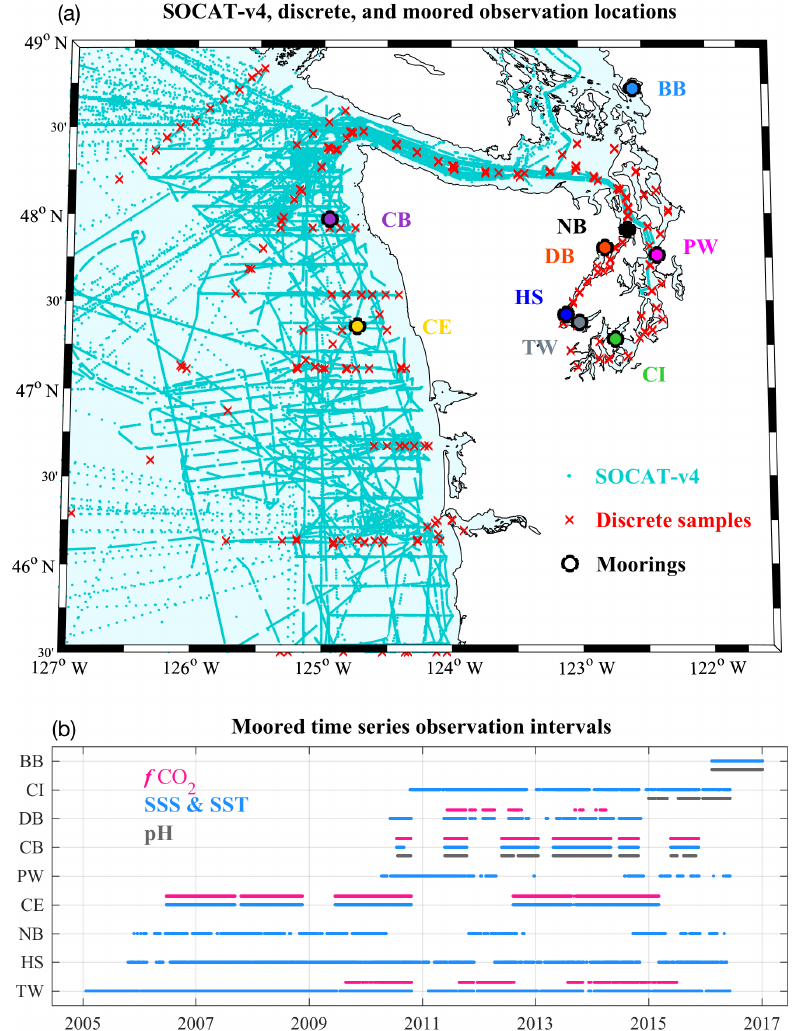
Figure 1. (a) Locations of coastal SOCAT-v4 f CO 2 observations, discrete sample stations, and moorings. The moorings are labeled with two-letter acronyms as follows: Bellingham Bay (BB), Carr Inlet (CI), Dabob Bay (DB), Chá b˘a (CB), Point Wells (PW), Cape Eliza- beth (CE), North Buoy (NB), Hoodsport (HS), and Twanoh (TW). (b) Intervals of available sensor data from each of the nine moorings. All moorings include salinity (SSS) and temperature (SST) observations (blue). Some moorings also include pH (gray) and/or f CO 2 (pink)